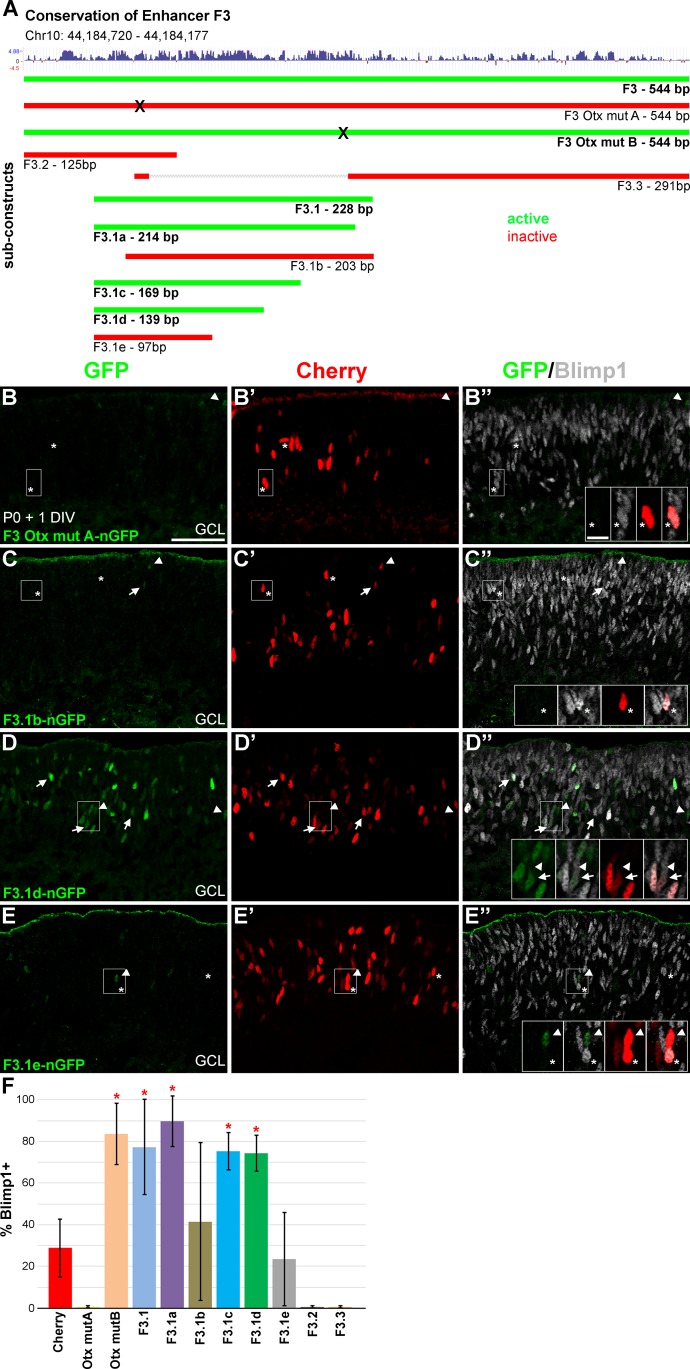
A 139bp region of element F3 recapitulates Blimp1 expression.(A) Schematic of the 544bp F3 region showing vertebrate conservation. Upward peaks indicate higher conservation. Genomic coordinates are from the mouse mm9 assembly. Ten sub-elements are shown to scale and color-coded based on their expression in explants cultured for 1DIV (green, active) (red, inactive). Mutagenesis of Otx2 sites to 6 A’s is marked with an “X”. (B-B”) Mutagenesis of the 5’ Otx2 “A” site blocks F3 activity and the rarely seen GFP+ cells (green, arrowheads) do not co-express Blimp1 (grey). Asterisks mark Cherry+ cells (red) that co-express Blimp1 (insets). (C-C”) The F3.1b sub-element, which contains 10bp of sequence 5’ of the Otx2 “A” site, has little activity. Of the few GFP+ cells seen, less than half co-express Blimp1 (arrows). Asterisks mark Cherry+ cells that co-express Blimp1 (insets) and arrowheads mark GFP+/Blimp1- cells. (D-D”) The 139bp F3.1d element is active in explants and most GFP+ cells co-express Blimp1 (arrows, insets). GFP+ cells that do not co-express Blimp1 are marked with arrowheads (insets). (E-E”) The 97bp F3.1e construct, which is shorter on the 3’ end than F3.1d, has little activity. Arrowheads mark GFP+/Blimp1- cells (insets) and asterisks mark Cherry+/Blimp1+ cells (insets). Scale bars are 50 μm for panels and 10 μm for insets. (F) Plot of the average percentage of GFP+ and Cherry+ cells that co-express Blimp1. Error bars represent the S.D. Otx2 mut B, F3.1, F3.1a, F3.1c, and F3.1d show significant (*, unpaired t-test, P < 0.05) Blimp1 co-expression compared to cherry control. These five active elements do not show differences in Blimp1 co-expression (ANOVA, P > 0.05).